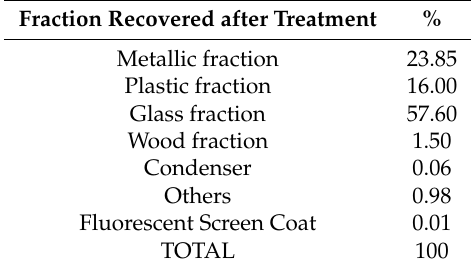
Table 2. Material fractions recovered after treatment.